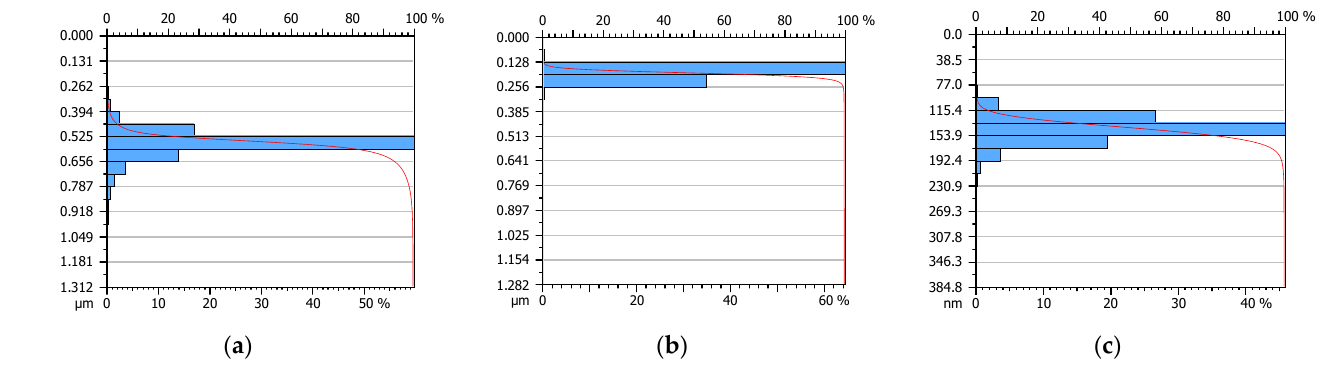
Figure 15. Abbott-Firestone curves of surfaces: base no. 1 ( a ), modified no. 2 ( b ) and modified no. 3 ( c ).